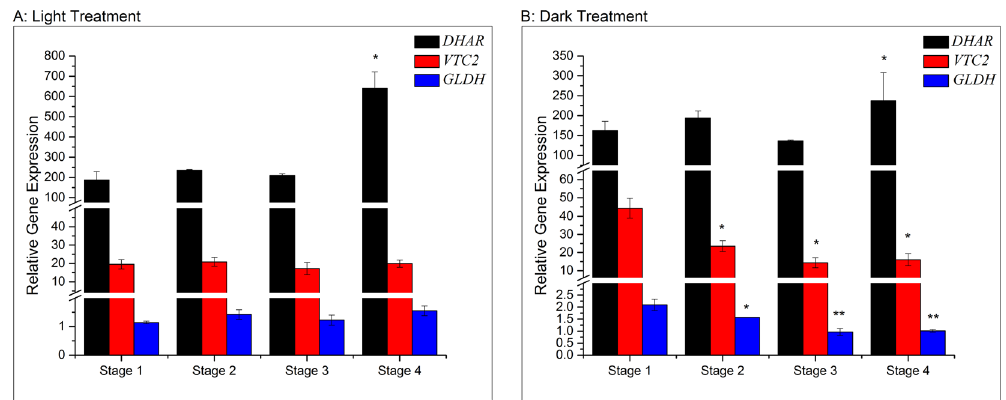
Figure 4. Changes of relative expression level of relevant genes in Vitamin C biosynthetic pathway during sweet corn seed germination; Bars with * and ** indicates significant difference at p < 0.05 and p < 0.01 respectively compared to stage 1. ( a ) Light treatment; ( b ) dark